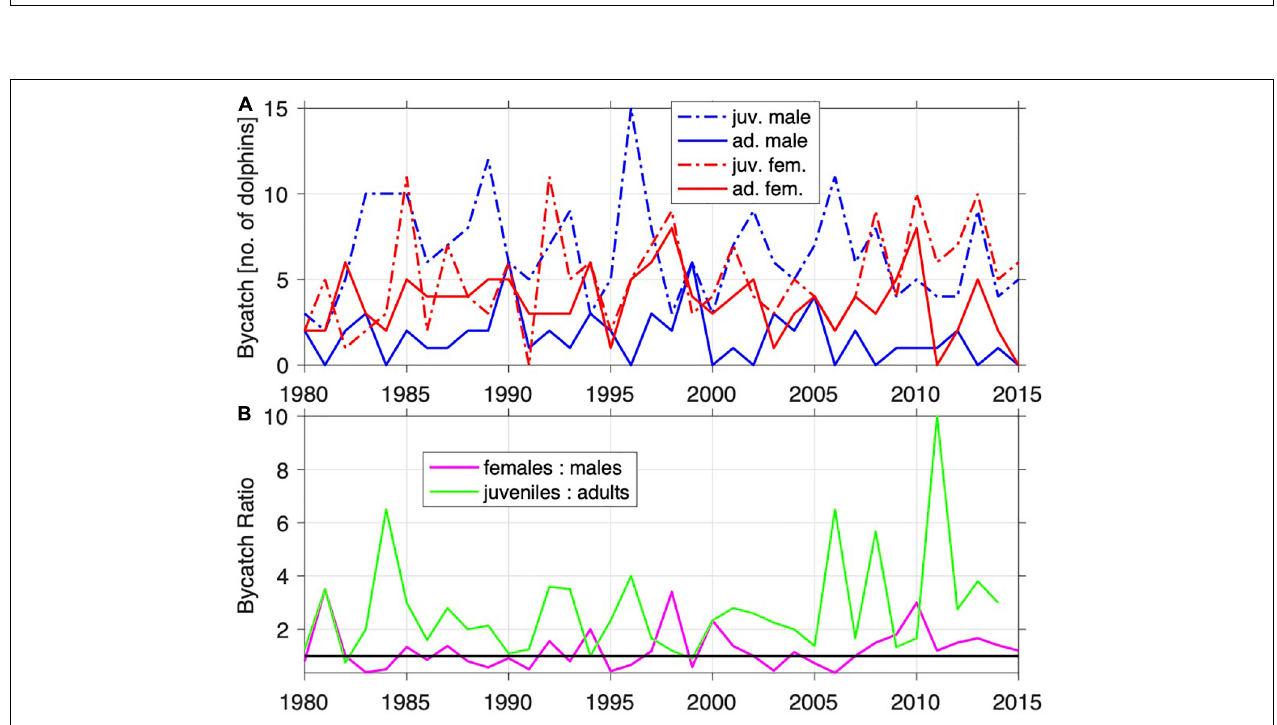
FIGURE 6 | Annual Indo-Pacific bottlenose dolphin ( T. aduncus ) bycatch from the NC by sex and sexual maturity (A) and ratios of sex and sexual maturity (B) .